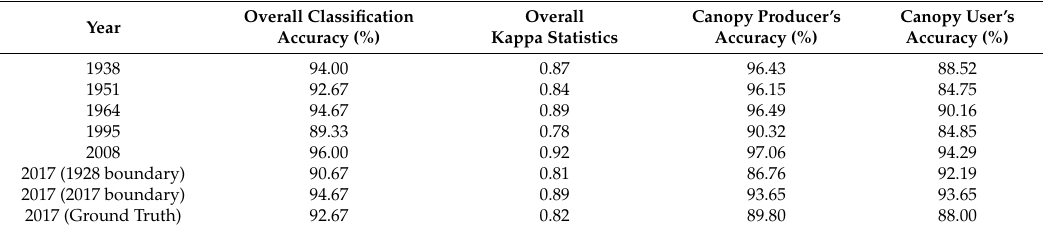
Table5. OBIAerrormatrix: overallclassificationaccuracy%, overallKappastatistics, canopyproducer’s accuracy % and canopy user’s accuracy %.